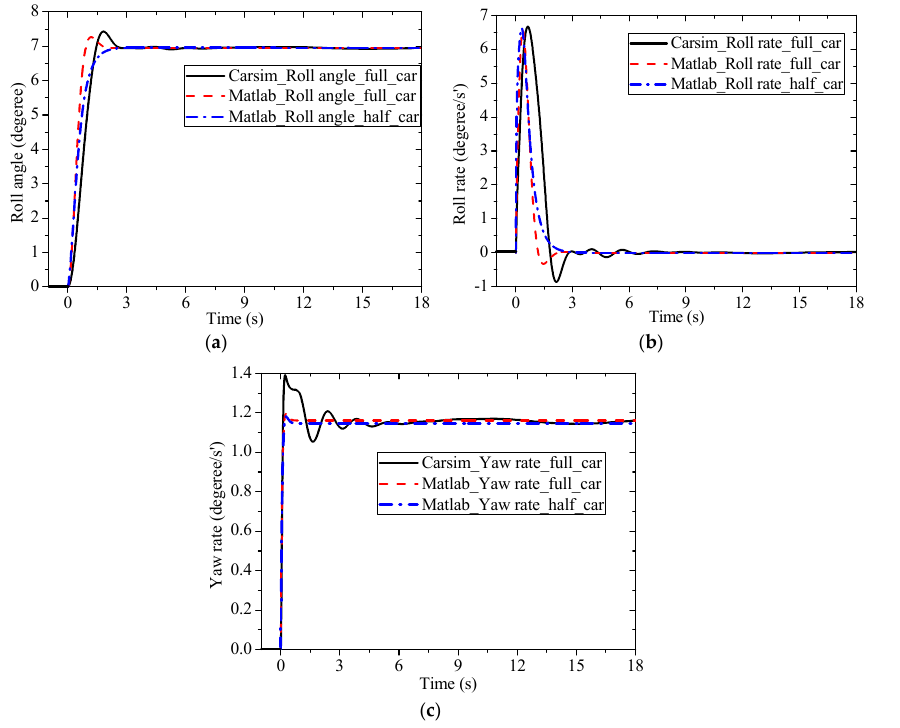
Figure 9. Results without road excitation (steering wheel angle was 10° at 80 km/h). ( a ) Roll angle, ( b ) Roll rate, ( c ) Yaw rate.